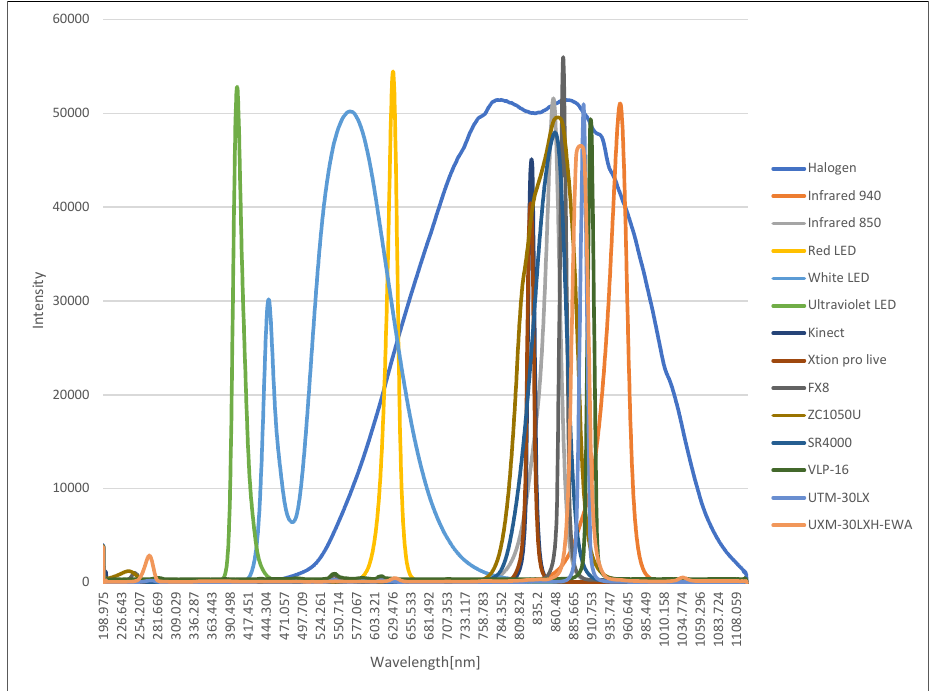
Figure 6. Spectral profiles of light sources and safety-related sensors